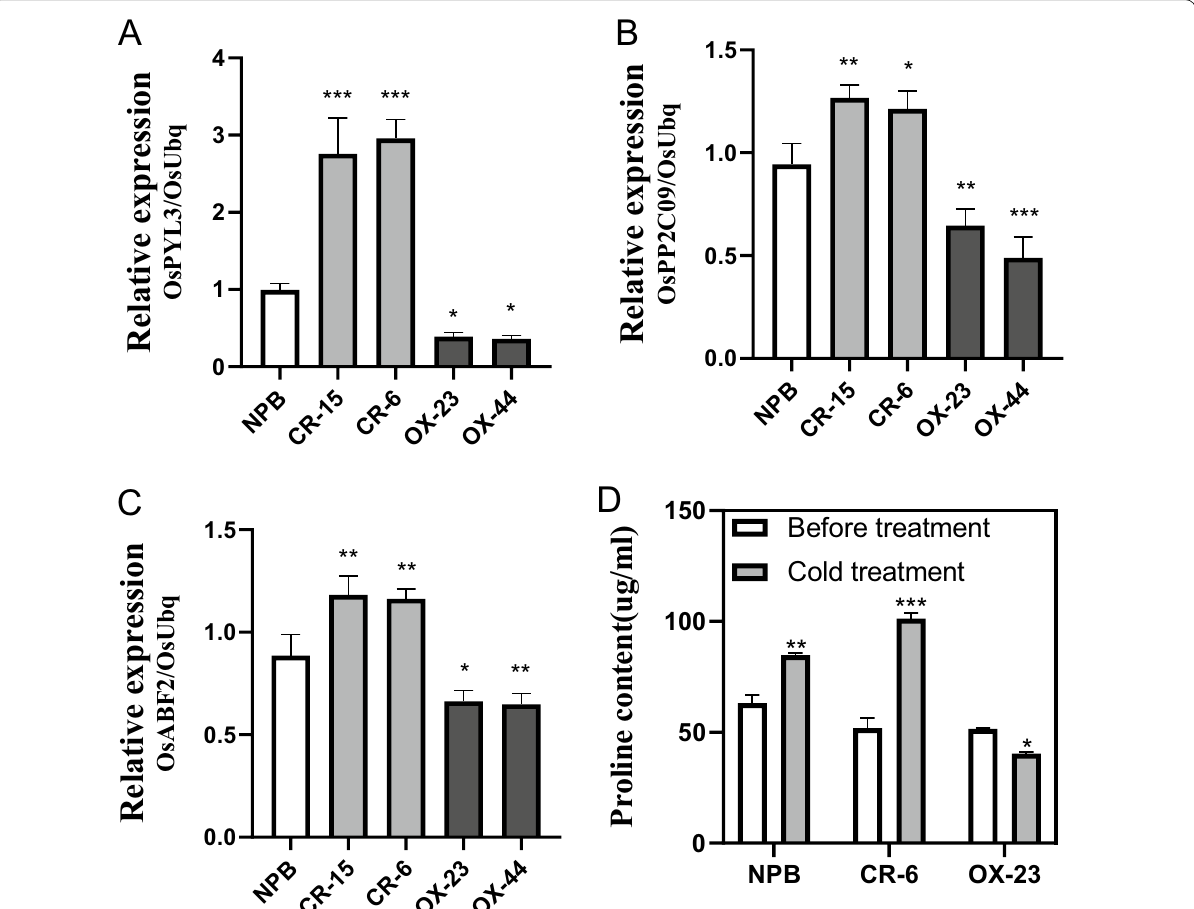
Fig. 5 Expression analysis of the three ABA‑related genes and proline content in OsRab11C1 transgenic lines. Relative gene expression levels of OsPYL3 ( A ), OsABF2 ( B ) and OsPPC09 ( C ) in OsRab11C1 transgenic lines. The X‑axis represents the knockout lines (CR‑6, CR‑15), the overexpression lines (OX‑23, OX‑44) and wild‑type Nipponbare (NPB). The Y‑axis shows relative gene expression. D Proline content of the OsRab11C1 transgenic and NPB lines after 4 °C cold